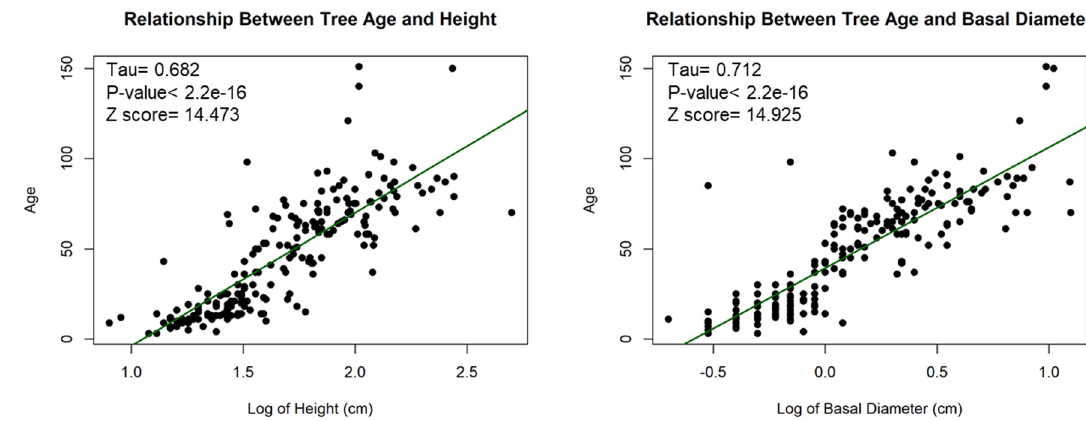
Figure 13. The relationship between log of basal diameter and tree age as well as log of height and tree age.